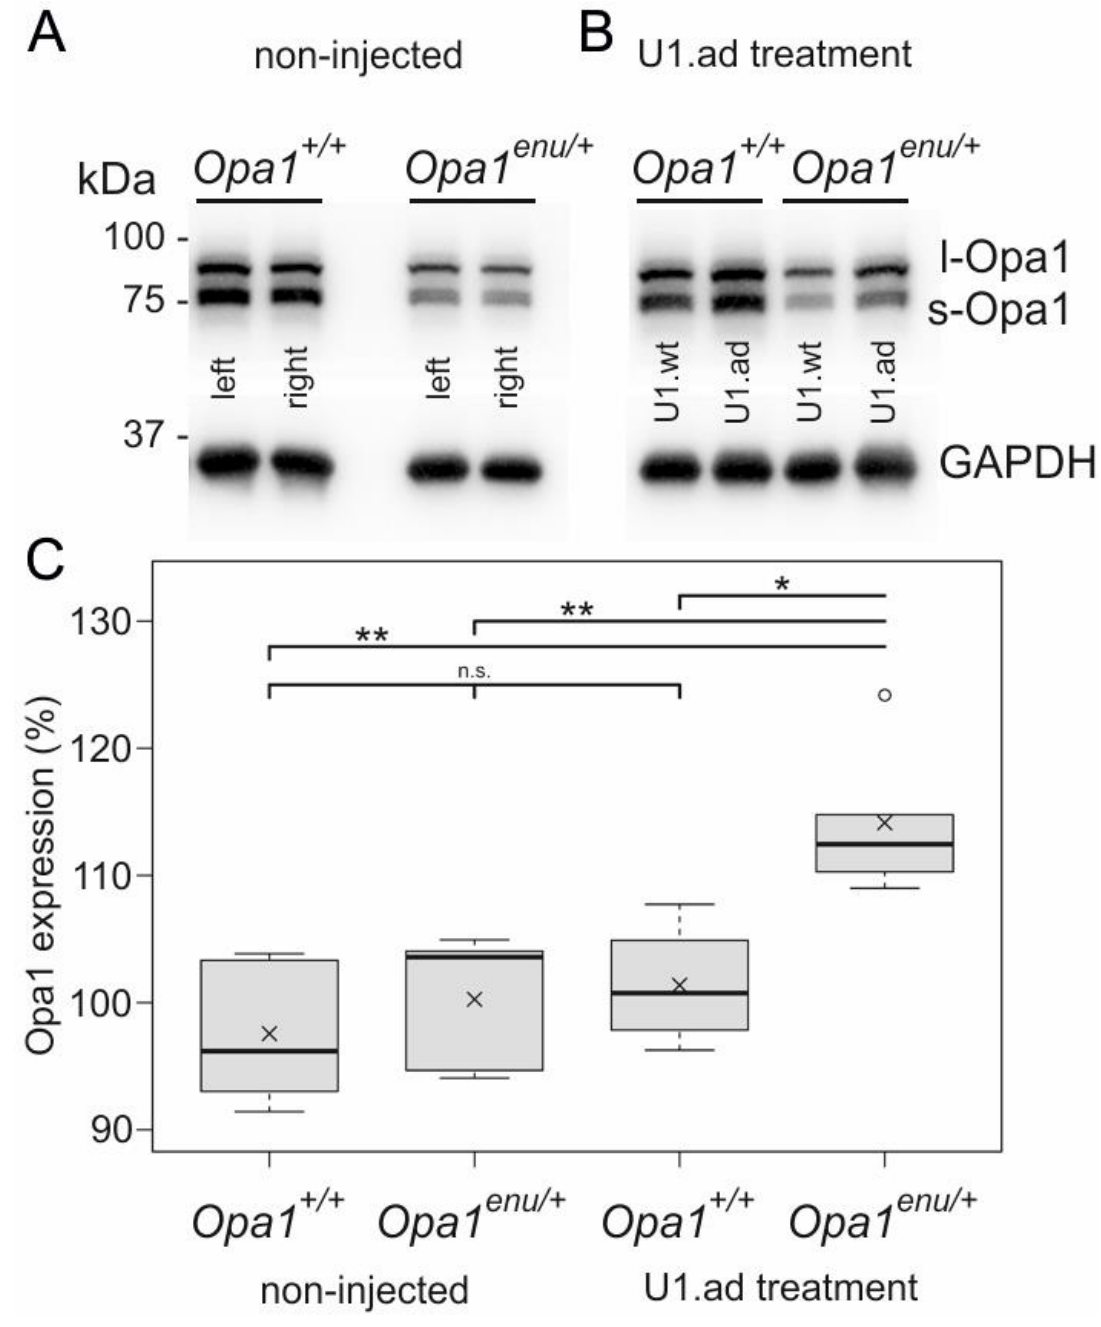
Figure 2. Treatment with engineered U1 specifically increased Opa1 protein expression in Opa1 enu/+ mutant mouse eyes. ( A, B ) Western blot analyses of Opa1 protein expression in total homogenates of retina and RPE. Left and right eyes of each animal are shown next to each other. GAPDH was used as a loading control. ( A ) In non-injected animals, Opa1 protein expression was reduced in Opa1 enu/+ eyes compared to wild-type eyes. ( B ) Opa1 protein levels were not changed in wild-type eyes upon U1 treatment (left). In Opa1 enu/+ eyes injected with engineered U1 (U1.ad), Opa1 protein levels were increased compared to the contralateral control eye injected with U1.wt (right). ( C ) Opa1 enu/+ eyes, but not wild-type eyes, treated with engineered U1.ad showed a significant increase of Opa1 protein relative to control (U1.wt) treated contralateral eyes. Quantification of Western blots was performed by comparing Opa1 protein expression of one eye (set to 100% as internal control) to the contralateral eye of the same animal. Statistical significances were calculated by Mann-Whitney U tests. ** p < 0.01; * p < 0.05; n.s., not significant, p > 0.05.